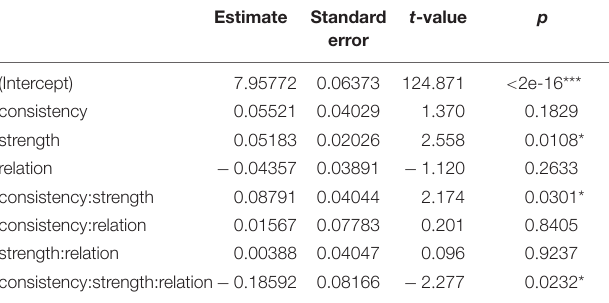
TABLE 7 | Model output of Experiment